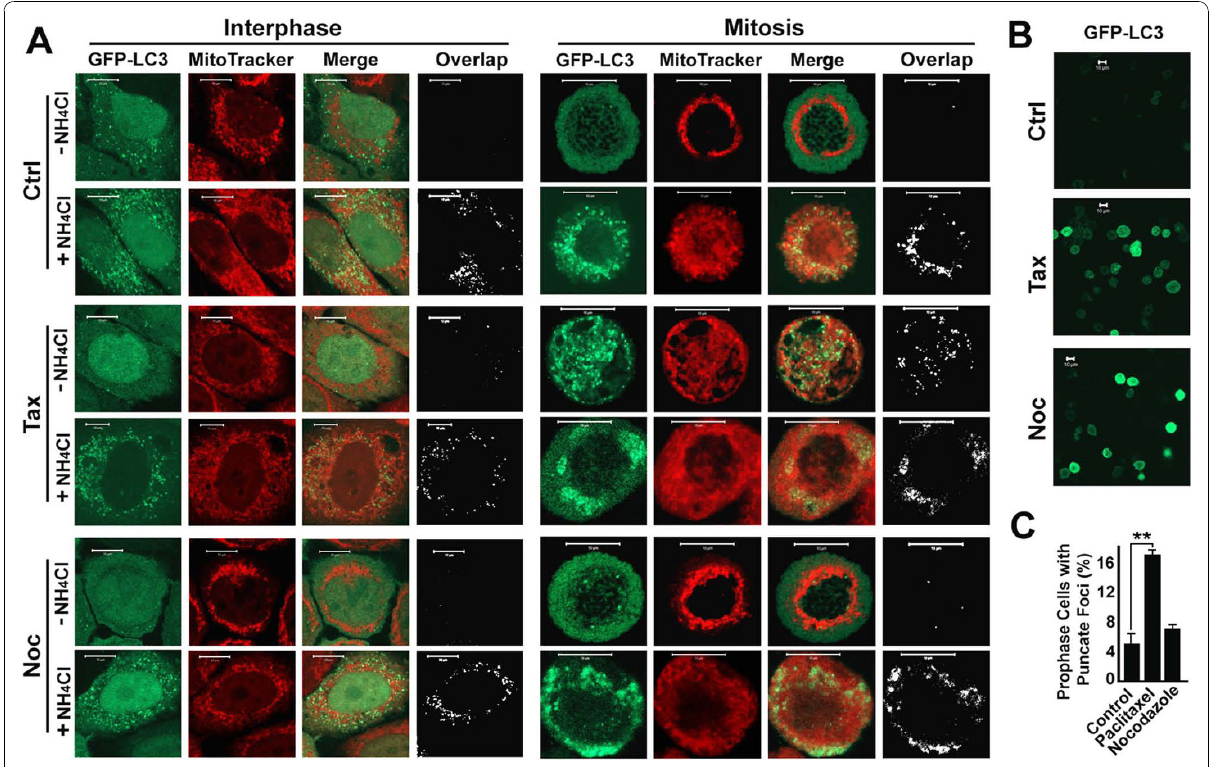
Figure 1 Only paclitaxel causes accumulation of punctate foci of GFP-LC3 in mitotic cells . ( A ) Accumulation of GFP-LC3 punctate foci in cells treated with either paclitaxel or nocodazole overnight. Mitochondria are shown in red after exposure to MitoTracker Red CMXRos dye [32,39]. The punctate foci of bright green GFP-LC3 in stably transfected HeLa cells overlapping with weak red punctate foci of dysfunctional mitochondria are indicative of mitophagosomes or mitolysosomes (mitochondria-containing autolysosomes). Colocalized punctate foci in white were revealed by analysis with an ImageJ ColocalizeRGB Plugin. The GFP-LC3 punctate foci overlapping with the much weaker signal of MitoTracker were not detected in the colocalization analysis. Lysosomal inhibitor NH 4 Cl (20 mM NH4Cl) was added simultaneously to preserve the resulting mitophagosomes. Scale bar, 10 μ m in all panels. Ctrl, Control, Noc, 10 μ M nocodazole; Tax, 10 μ M paclitaxel. ( B ) Fluorescent intensity of GFP-LC3 in mitotic cells treated with paclitaxel and nocodazole overnight. ( C ) The percentage of pro-metaphase cells with punctate foci of GFP-LC3 as shown for the mitotic cells treated with paclitaxel overnight in the absence of NH 4 Cl (A). Number of cells with GFP-LC3 punctate foci was counted directly and expressed as a percentage of total mitotic cells. Because of the difference in frequency of mitosis, about 100 mitotic cells in 20 to 50 different fields were scored in the presence or absence of nocodazole or paclitaxel, respectively. The data represent the means and standard errors of three independent experiments. **, p < 0.01 as calculated by Student ’ s